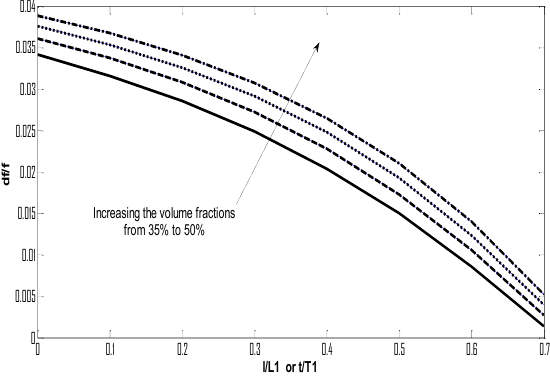
00 . Fig.4: The responses of the RBCs for the same volumes at different volume fractions (0.35, 0.40, 0.45, 0.50) Fig.4 shows the responses of the RBCs with four different volume fractions, which are 35%, 40%, 45% and 50%. All responses are shown as parallel lines, where the same volumes of the RBCs give different values of the frequency shifts, because of different volume fractions.